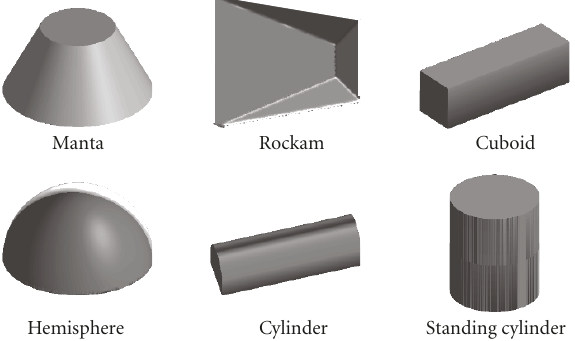
Figure 4: 3D models of the di ff erent targets and minelike objects. of the e ff ects of resolution on classification performance.